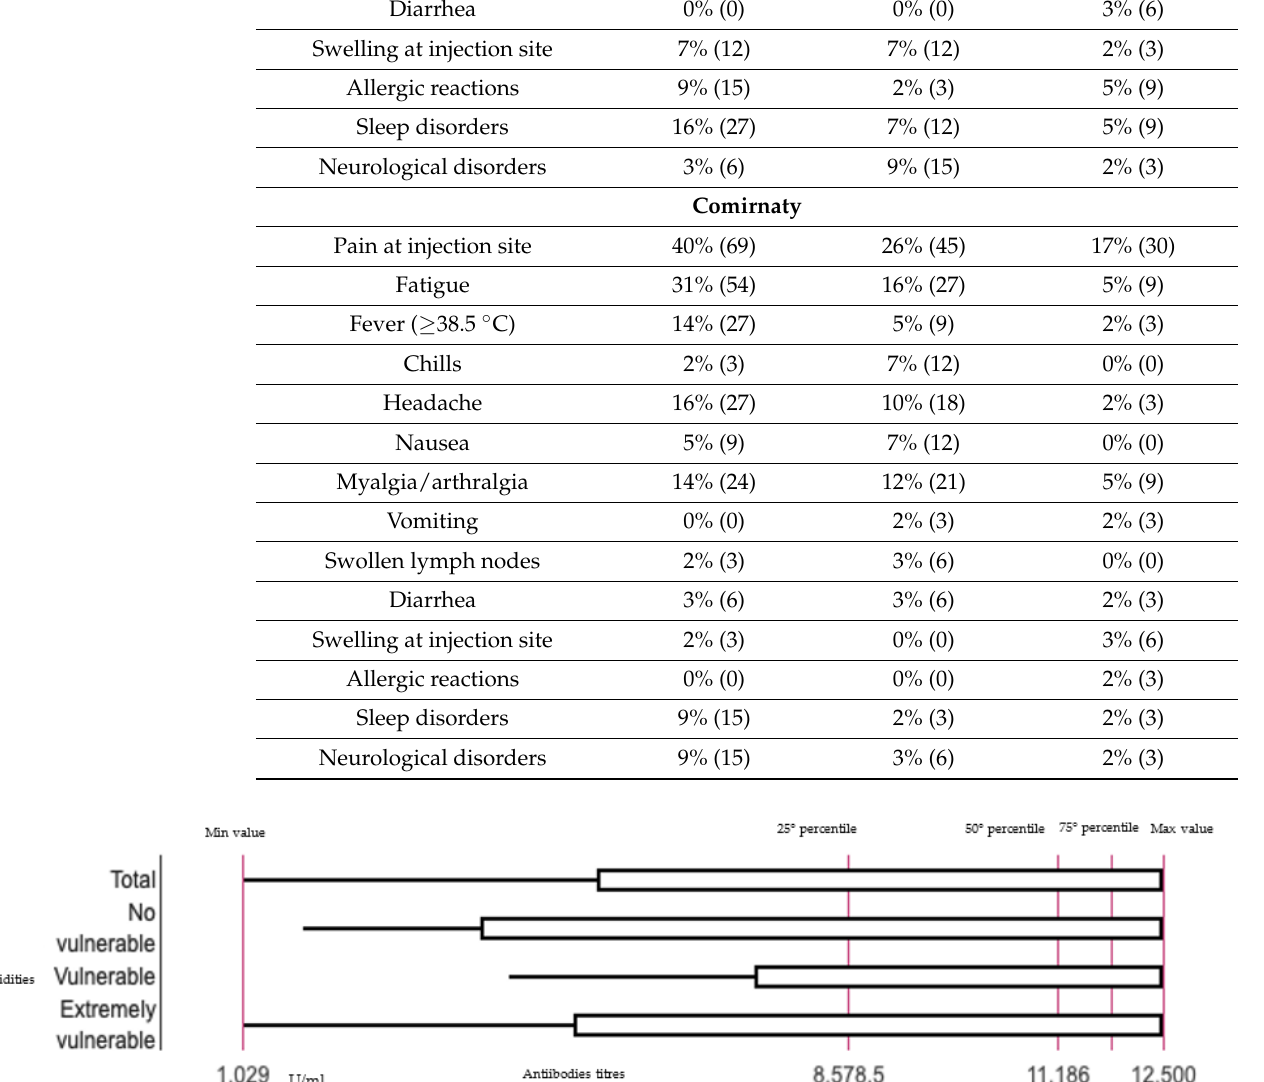
Figure 1. Boxplot representing the distribution of the antibody titers after heterologous schedule on total sample and by comorbidities.